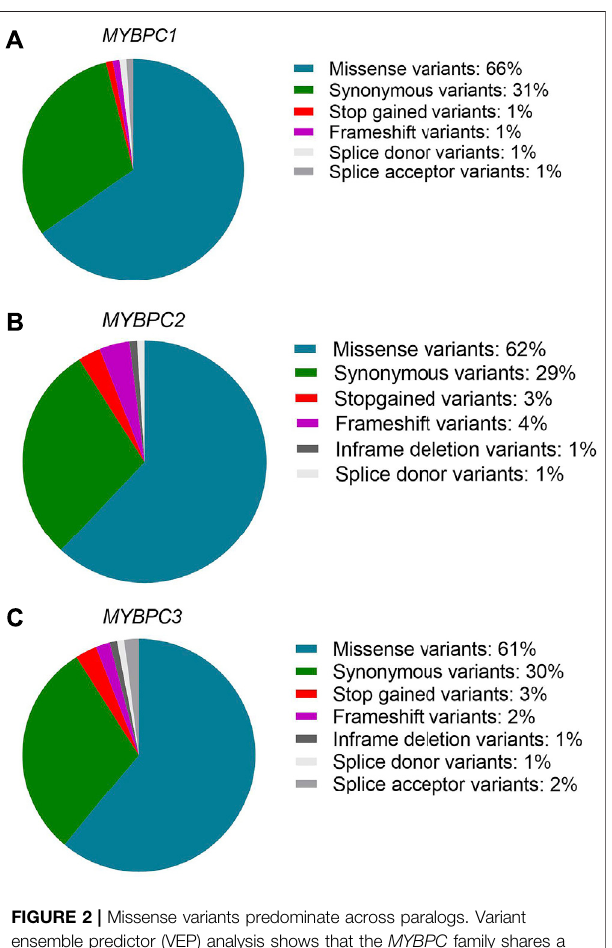
FIGURE 2 | Missense variants predominate across paralogs. Variant ensemble predictor (VEP) analysis shows that the MYBPC family shares a similar pattern of variant distribution, predominantly comprised of single nucleotide variants (61% – 66% missense variants, 30% synonymous variants). The remainder includes stop-gain, splicing variants, non-frameshift variants and frameshift variants in MYBPC1 (A) , MYBPC2 (B) , and MYBPC3 (C) genes. FIGURE 3 | Variant frequency is characterized by heterogeneity in